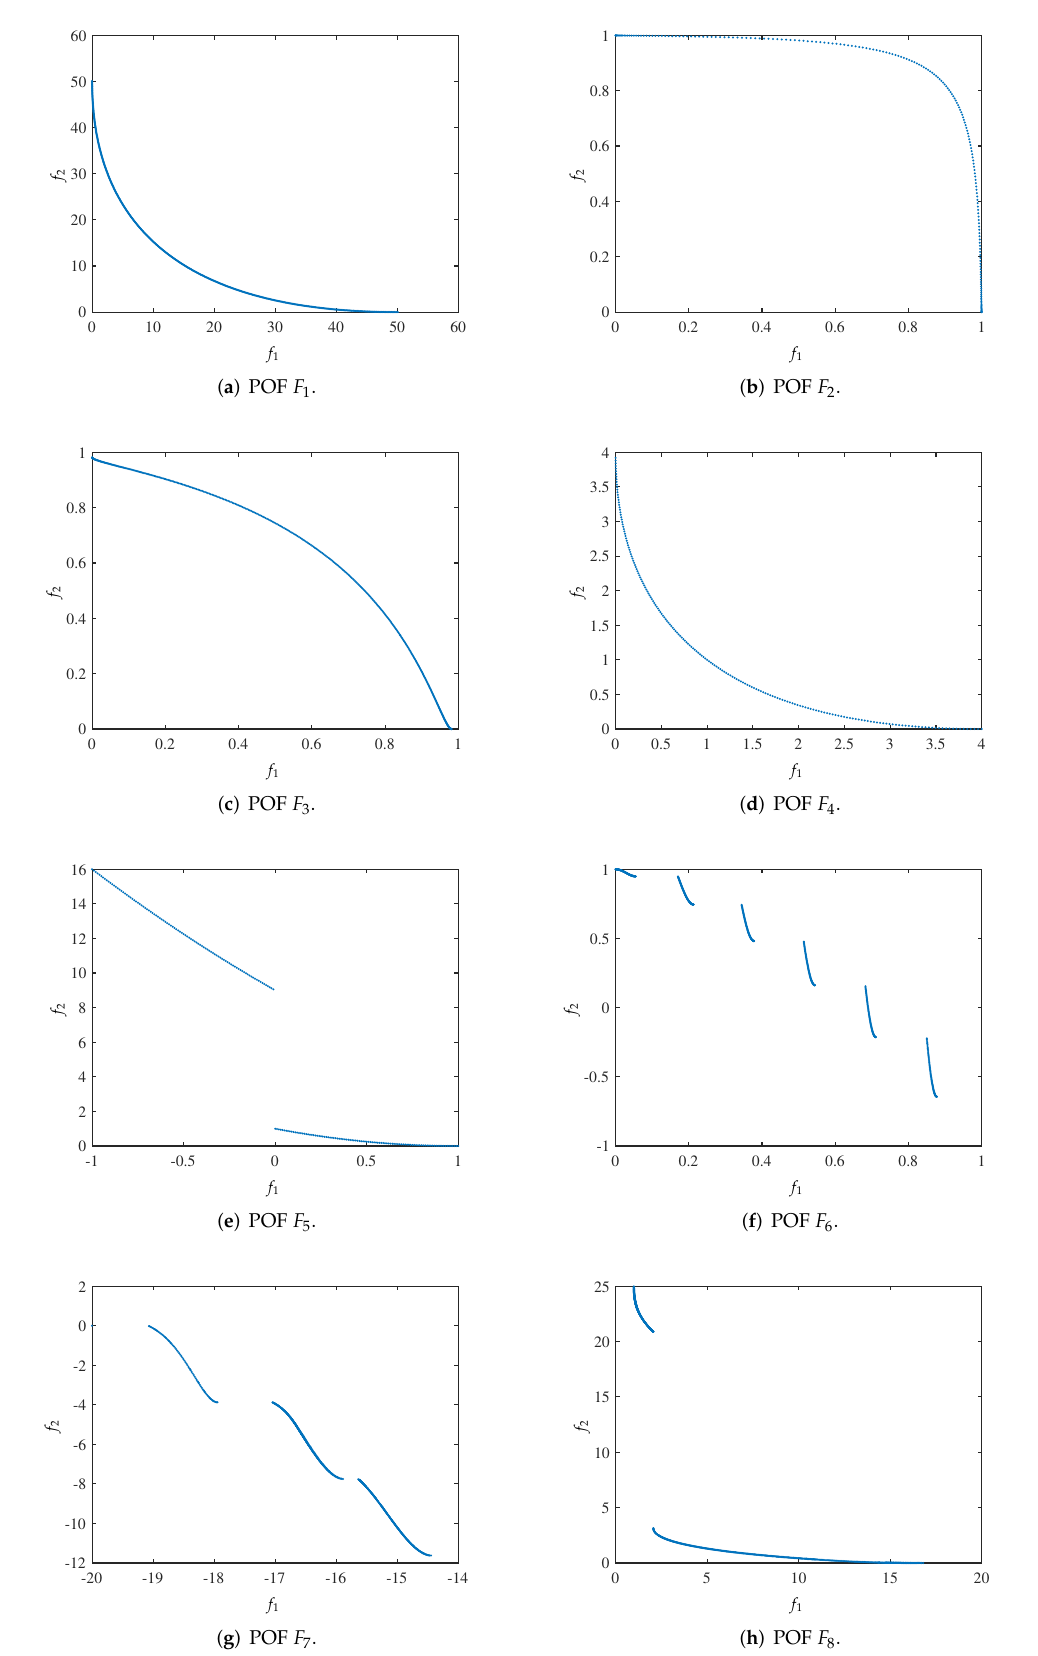
Figure 4. Pareto optimal fronts for the considered test functions F 1 to F 8